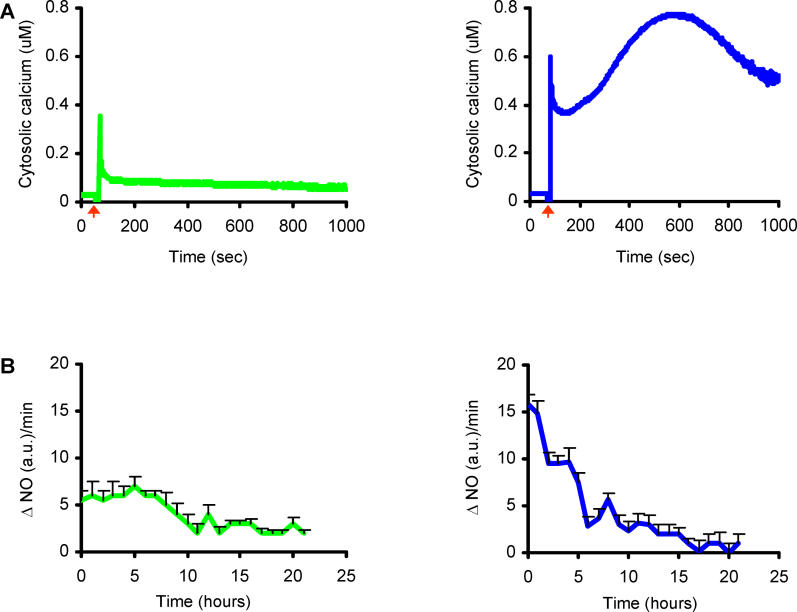
The Role of NO and Calcium in Acclimation to Sublethal Doses of DD(A) Cytosolic calcium transients in transgenic P. tricornutum cells expressing Aequorin. Left panel shows calcium response in non-pretreated cells (green) following addition of 13.2 μM (2 μg/ml) DD (indicated by arrow), whereas right panel shows the calcium signature of cells that had been pretreated with 660 nM (0.1 μg/ml) DD for 2 h prior to addition of 13.2 μM (2 μg/ml) DD (blue).(B) Relative rate of NO production in pretreated (blue) and non-pretreated (green) cells. Experimental conditions as in (A).Representative data from five experiments is shown in (A). Data in (B) are means plus standard deviation from five experiments.a.u., arbitrary units.